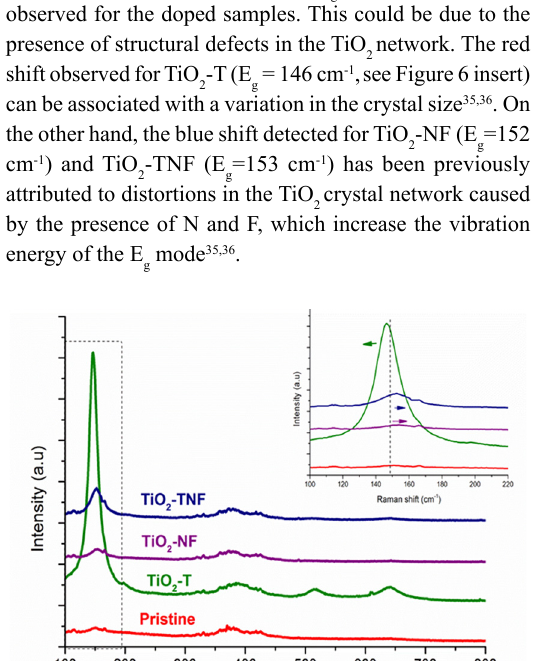
Figure 6. Raman spectra for TiO TiO -TNF films after hydrothermal treatment and annealing at 400 2